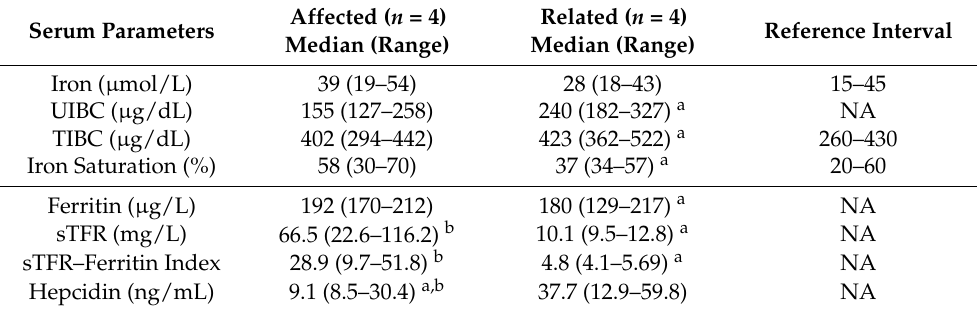
Table 3. Serum iron parameters in English springer spaniels with DAMS and related healthy dogs. Serum